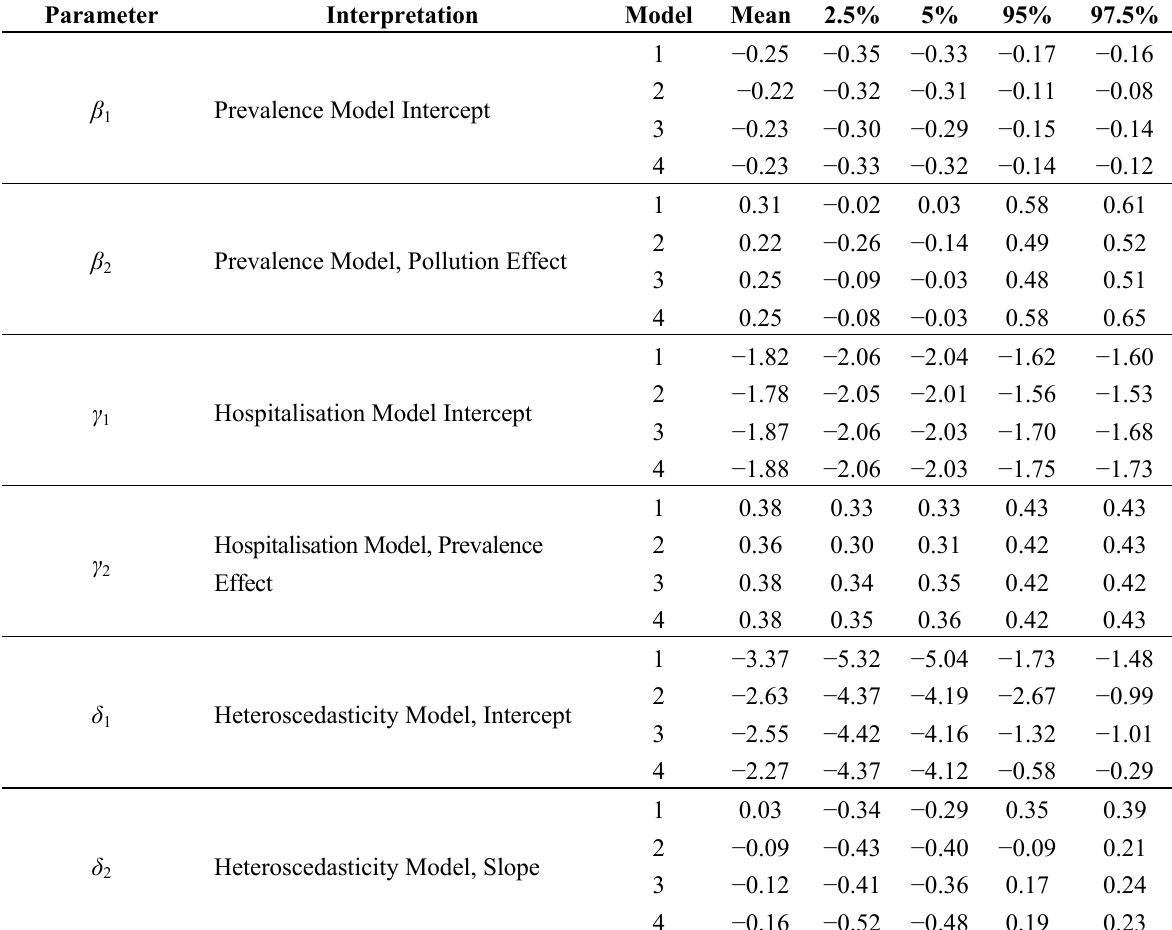
Table 2. Posterior summary (means and quantiles), structural parameters.